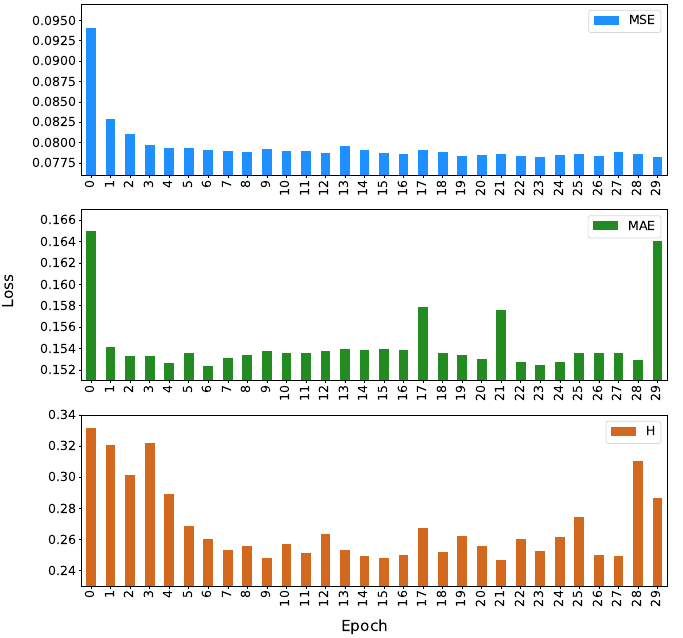
Figure 3. Long Short-Term Memory loss parameter by epochs based on the CIC-IDS2017 dataset.